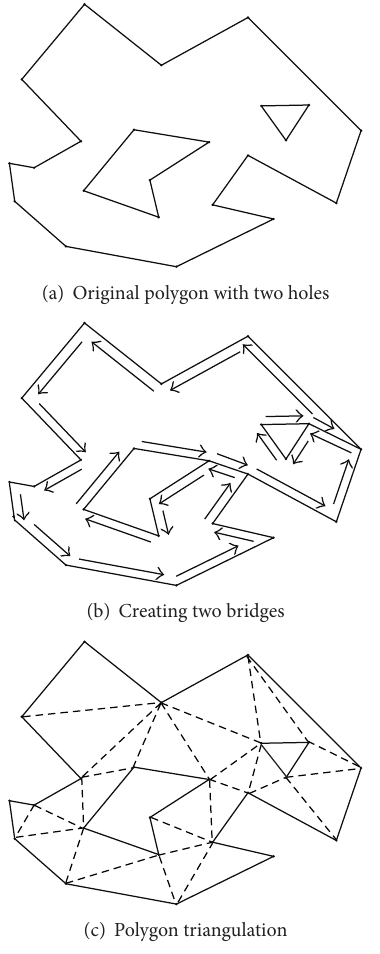
Figure 2: Creating bridges and triangulation for the polygon with holes